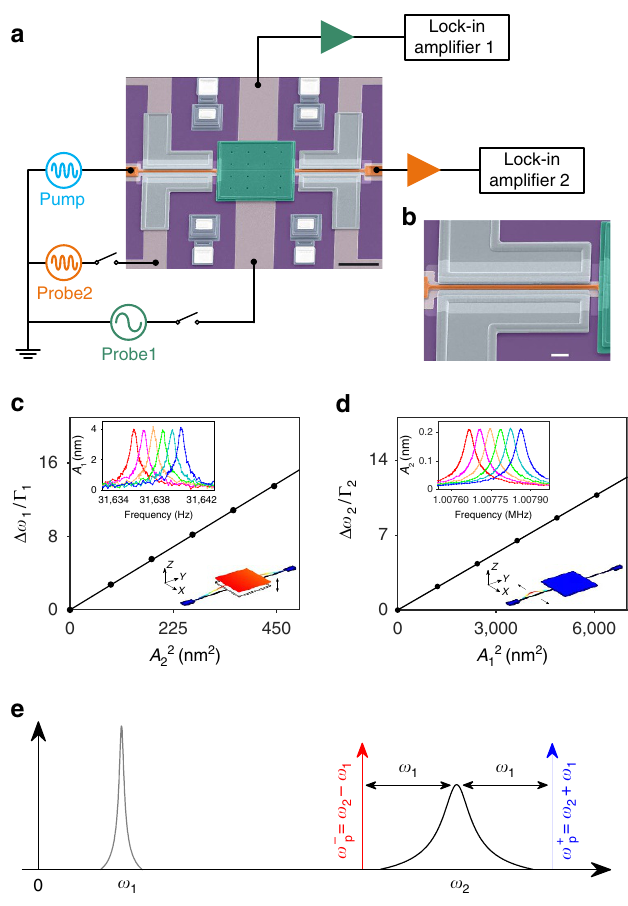
Figure 1 | Dispersive coupling of the plate and beam modes of the electromechanical resonator. ( a ) Scanning electron micrograph of the electromechanical resonator (colourized) and a schematic of the measurement circuitry. The black scale bar at the lower right corner measures 50 m m. ( b ) Close-up scanning electron micrograph of the beam. The white scale bar measures 10 m m. ( c ) The scaled shift of the resonance peak of the plate mode D o 1 / G 1 versus the vibration amplitude square of the beam mode A 2 . The error bar is smaller than the dot size. The line is a linear fit. Upper inset: spectra of the plate mode measured with a small probe voltage (Probe1). A 2 is increased from zero in steps of 89nm 2 . Lower inset: 2 vibration profile of the plate mode. ( d ) A similar plot for the beam mode. Upper inset: the squared plate mode amplitude A 1 2 is increased in steps of 1,215nm 2 . ( e ) A sketch of the spectra of the plate mode and the beam mode centred at the mode frequencies o 1 and o 2 , respectively. The low- and high-frequency sidebands are marked as red and blue arrows, respectively.